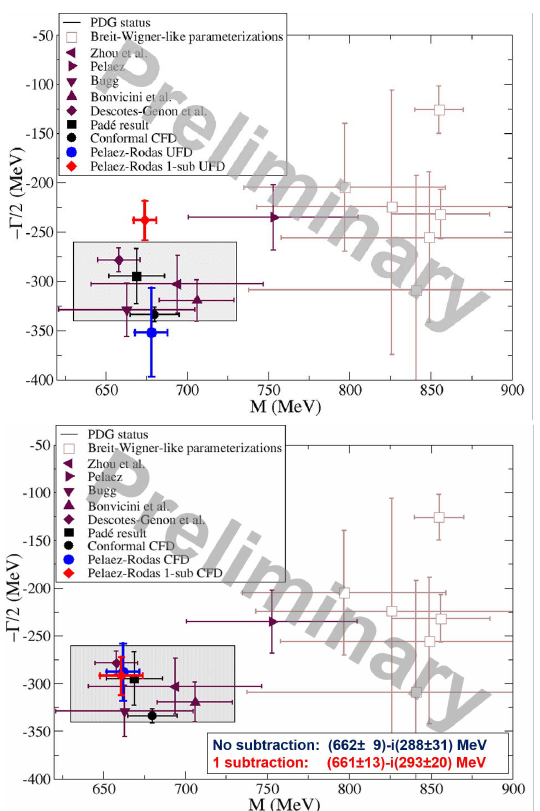
Figure 3. Preliminary results for the κ/ K ∗ (700) pole from a Roy-Steiner analysis. For comparison, we 0 show the T -matrix poles listed in the RPP [1] (see references therein) and the grey rectangle stands for the uncertainty presently estimated there [1]. In the top panel we show how, even with the same UFD input, the red and blue poles, respectively obtained using one or no subtractions for F − yield incompati- ble values. In contrast, we show in the lower panel that, when using our simple CFD parameterizations, the two red and blue poles come out consistently, determining precisely the κ/ K ∗ (700) pole position at 0 the red and blue numerical values quoted in the inset rectangle, which are also